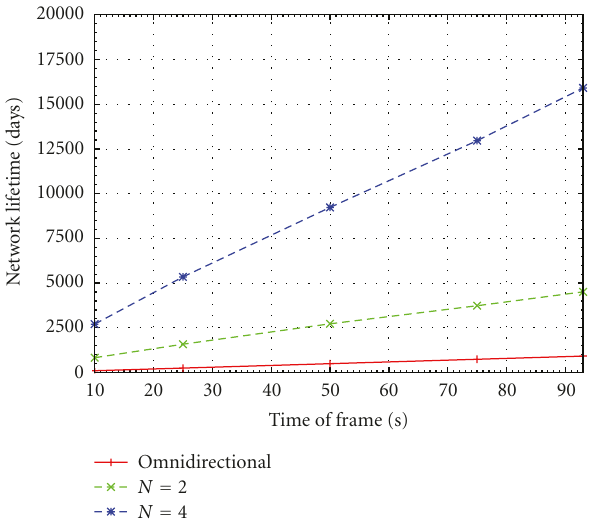
Figure 6: Network lifetime as a function of the frame duration T f in the case of omnidirectional and directive antennas with π or π/ 2 main lobes for T f = 93seconds and 50 nodes.